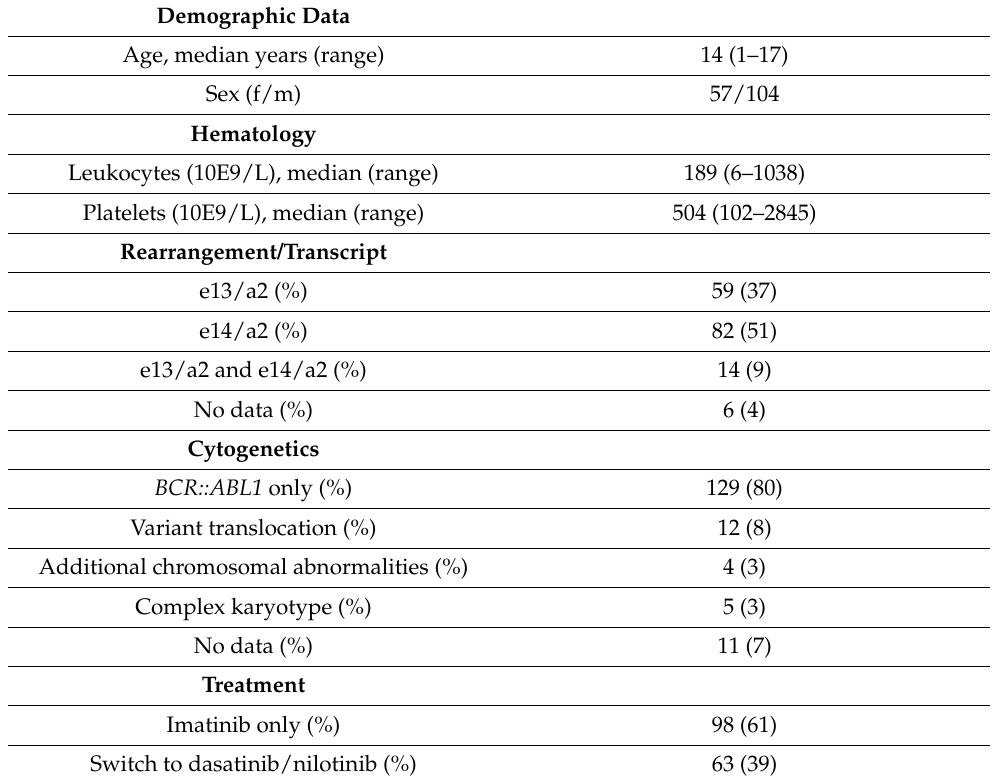
Table 1. Cohort characteristics of n = 161 pediatric patients of the CML-PAED-II-Cohort diagnosed in chronic phase